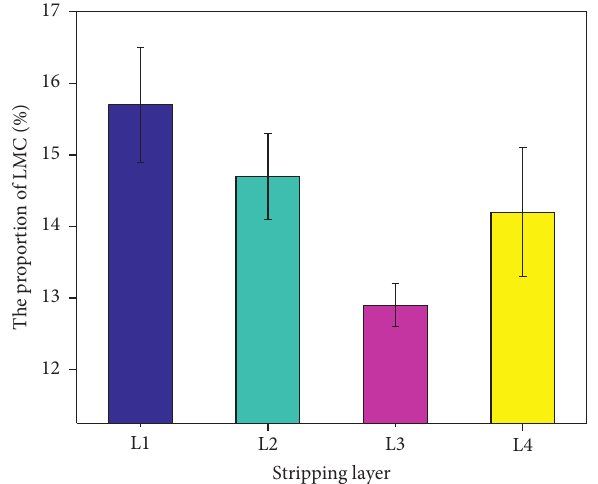
Figure 7: The LMC of asphalt at different